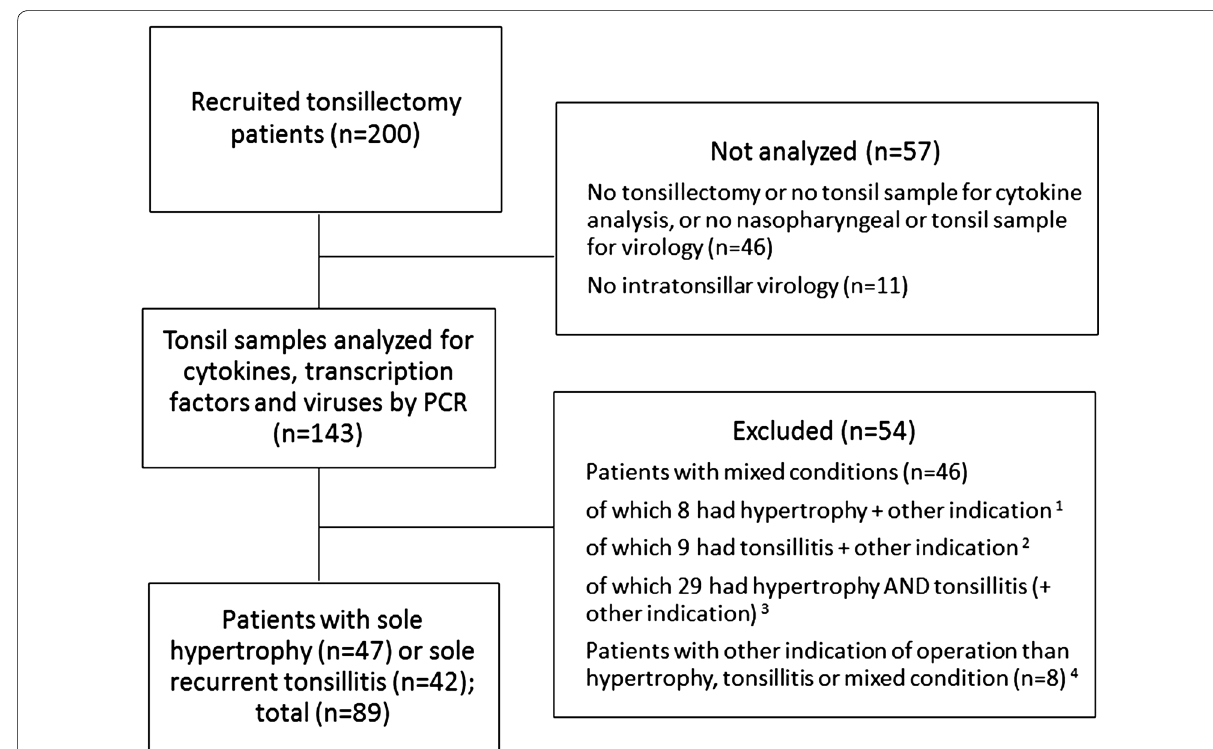
Fig. 1 Study flow chart. 1 8 had hypertrophy and another indication (recurrent otitis media n fever n 1). 2 9 had recurrent tonsillitis and another indication (recurrent fever n = 8 had hypertrophy, tonsillitis, and another indication (recurrent fever, n 4 8 had other indication of operation than hypertrophy or tonsillitis (chronic white patches in tonsils